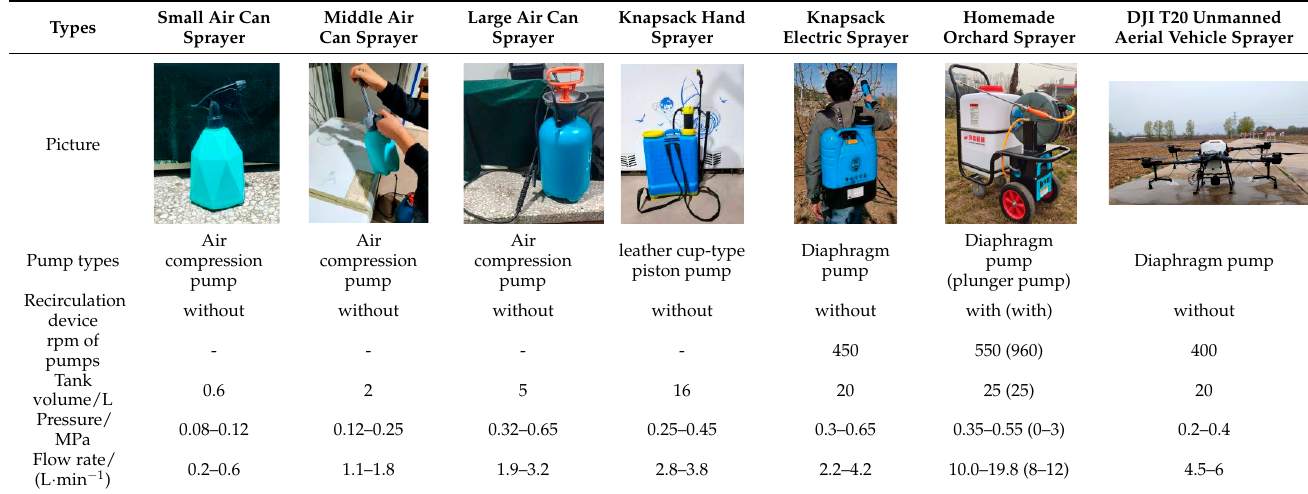
Table 2. Types and parameters of sprayers for the test. In this study, eight types of sprayers (three types of pumps) were used for LSP. The parameters of each sprayer were listed, including the type of pumps, recirculation device, revolutions per minute (rpm) of pumps, tank volume, pump pressure, and flow rate.